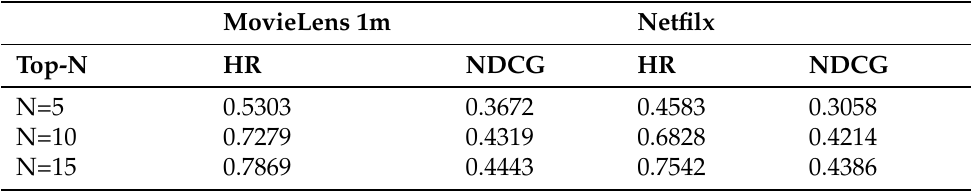
Table 5. The HR and NDCG values for different top-N